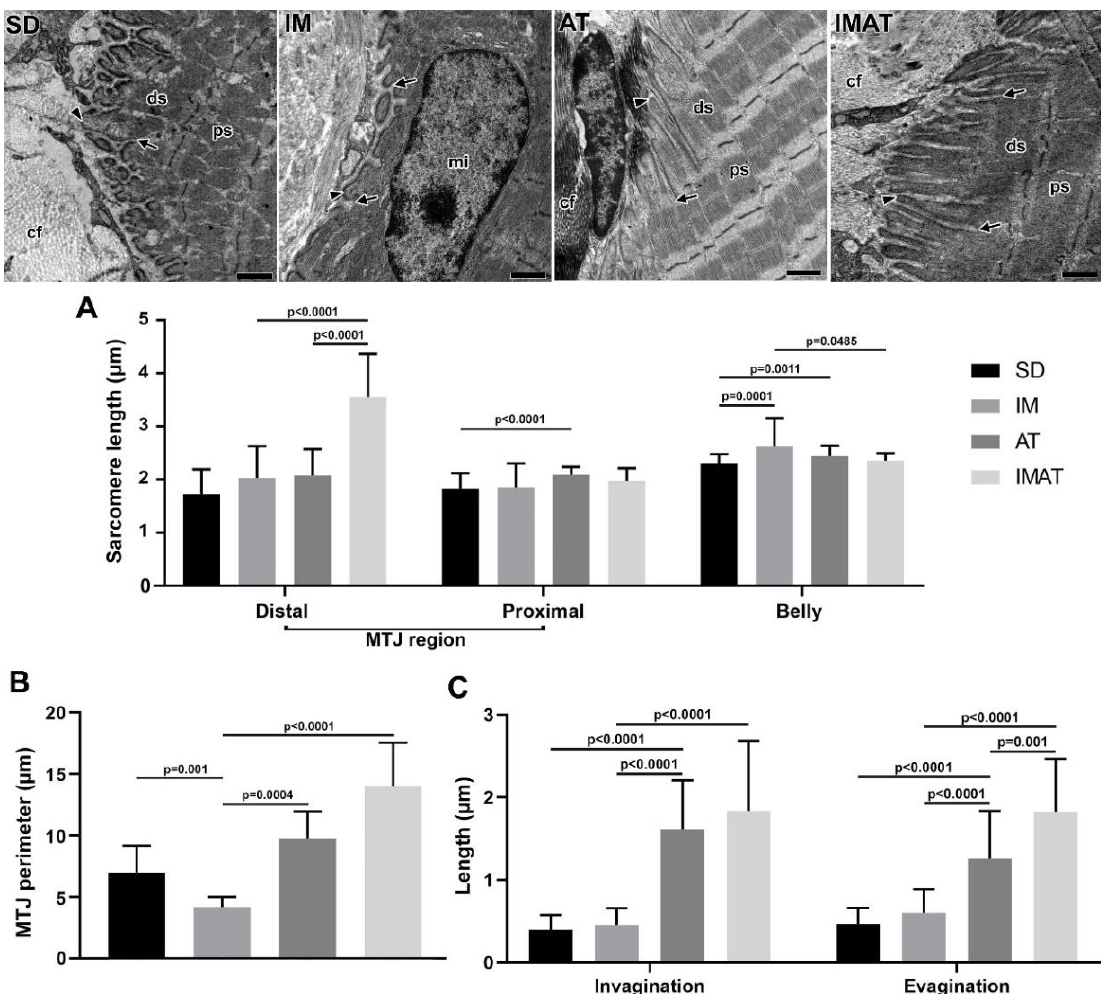
Figure 4. Transmission electron microscopy of MTJ region of sedentary (SD), immobilization (IM), aquatic training (AT), and immobilization/aquatic training (IMAT) from gastrocnemius muscle of Wistar rats. In the ECM collagen fibers (cf) organized in transversal and longitudinal form were observed, as well as the sarcoplasmatic invaginations (arrowhead) and evaginations (arrow) associated to distal (ds) and proximal (ps) sarcomeres; in IM group a centralized myonucleus (mi) in the muscle fiber was observed. Bars: 1 µ m. ( A ) Mean ± standard deviation of sarcomere length ( µ m) localized in the MTJ region, distal and proximal, and of the belly muscle of groups; distal sarcomere: IM and AT (cid:54) = IMAT ( p < 0.0001); proximal sarcomere: SD (cid:54) = AT ( p < 0.0001); belly sarcomere: IM (cid:54) = SD ( p = 0.0001), AT (cid:54) = SD ( p = 0.0011), and IM (cid:54) = IMAT ( p = 0.0485). ( B ) Mean ± standard deviation of MTJ perimeter determined in the contact area of 2 µ m between sarcoplasmatic invagination and evagination of groups; SD (cid:54) = IM ( p = 0.001), AT (cid:54) = IM ( p = 0.0004), and IM (cid:54) = IMAT ( p < 0.0001). ( C ) Mean ± standard deviation of length of sarcoplasmatic invagination and evaginations of groups; invaginations: AT (cid:54) = SD ( p < 0.0001), AT (cid:54) = IM ( p < 0.001), and IMAT (cid:54) = IM ( p < 0.0001); evaginations: AT (cid:54) = SD ( p < 0.0001), AT (cid:54) = IM ( p < 0.0001), IMAT (cid:54) = IM ( p < 0.0001), and IMAT (cid:54) = AT ( p =